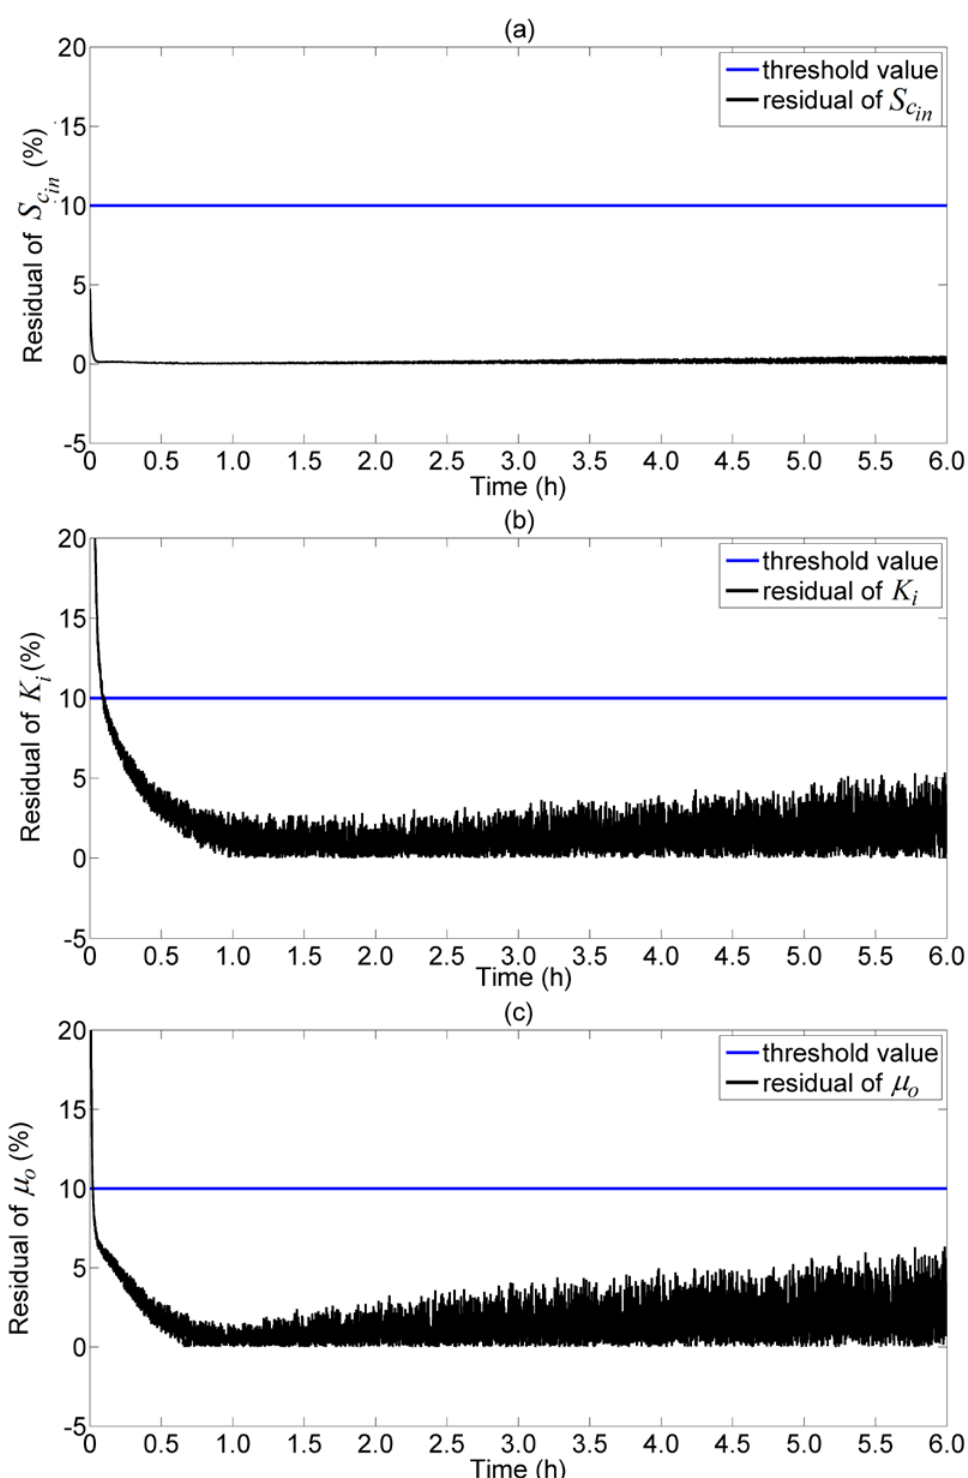
Figure 4. Residual of estimated model parameters for the fault-free scenario. ( a ) Concentration of substrate in the inflow,